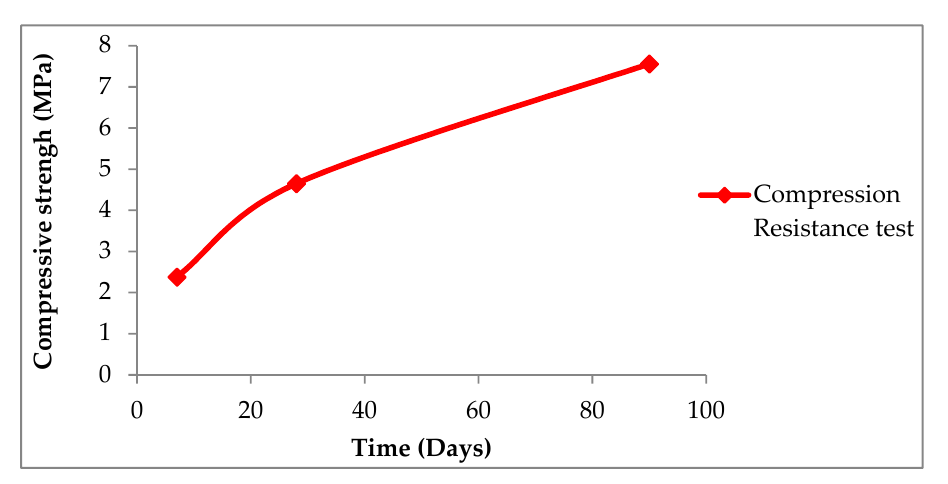
Figure 8. Compressive strength.